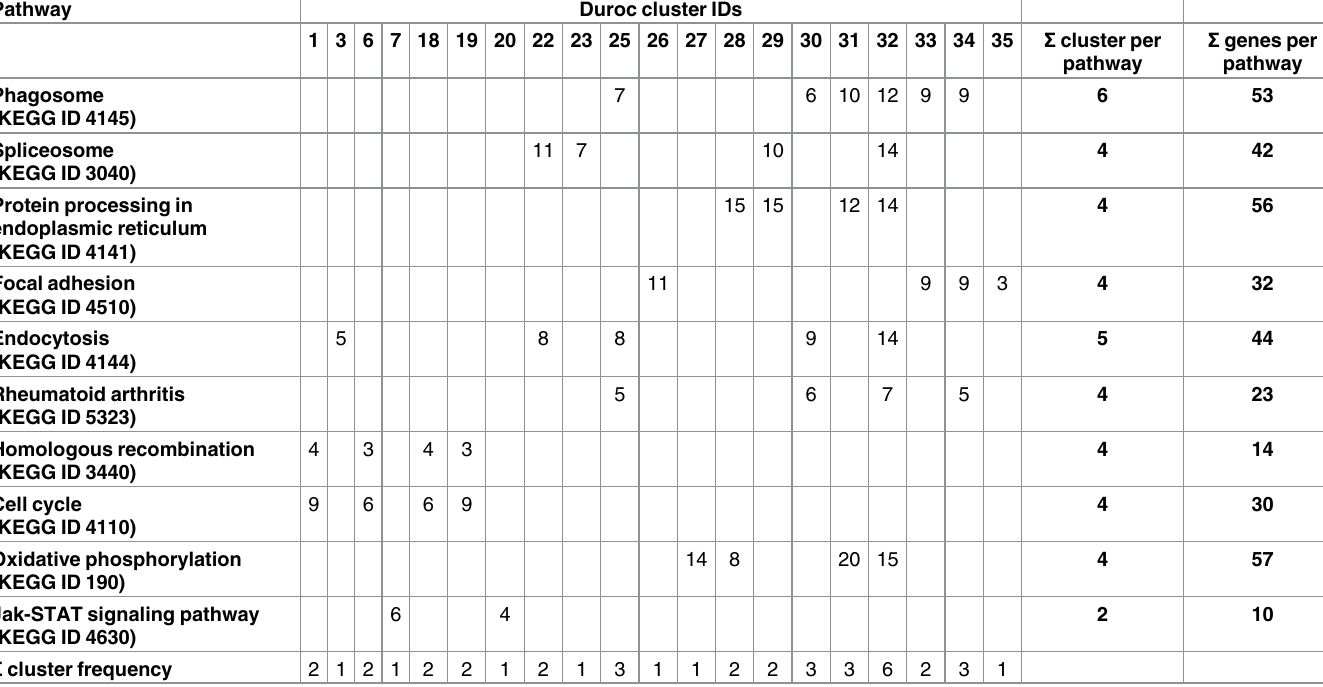
Table 2. Top 10 scored pathways using KEGG and clusteredRNA-Seq dataset post PRRSV infection, representedby the cluster ID of Duroc lung DCs.